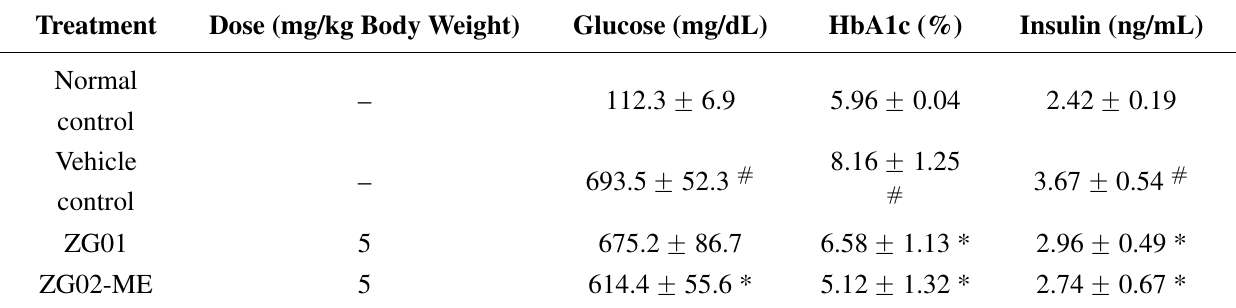
vehicle-treated control as determined by one-way